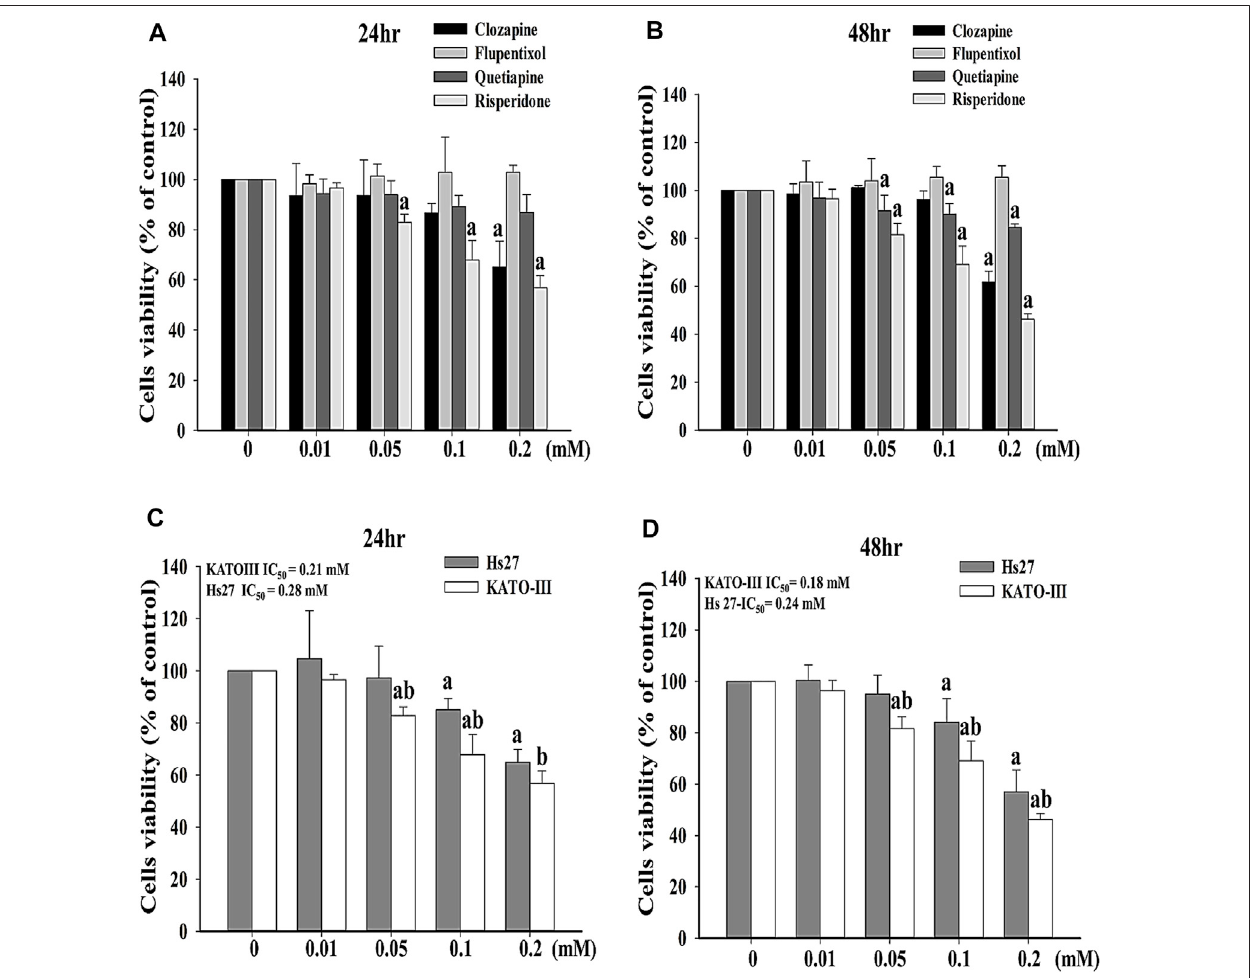
FIGURE 1 | Effects of different antipsychotics on survival of KATO-III cells. Cell viability of KATO-III cell in the presence of clozapine, fl upentixol, quetiapine, and risperidone for (A) 24 and (B) 48 h. Cell viability ofKATO-IIIand Hs27 cells in the presence ofrisperidone for (C) 24and (D) 48 h. Three-repeated tests were completed. The letters a and b indicate a signi fi cant difference ( p < 0.05) compared with control (0 mM) or Hs27, respectively.